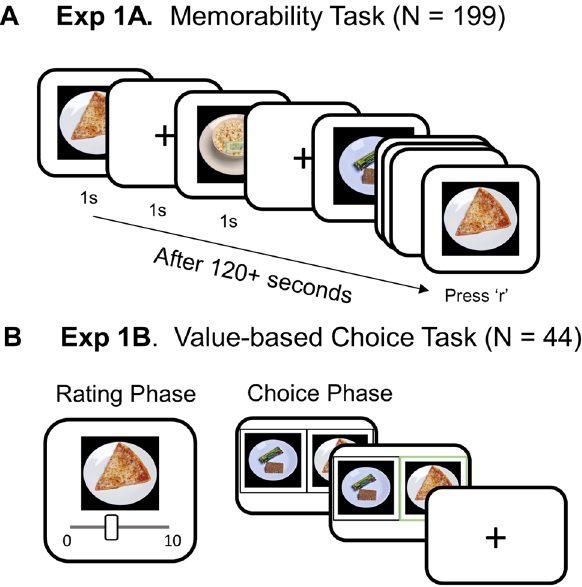
Figure 1. Diagram of tasks in Experiment 1. ( A ) Memorability task (Experiment 1A). Participants (N = 199) were asked to view a stream of images and press the ’r’ key on the keyboard if they saw a repeated image. Images were randomly classified as filler or target for each participant, and the spacing between the first and second display was different for targets and fillers. ( B ) Value-based choice task (Experiment 1B). In the rating phase, participants (N = 44) were asked to rate all of the 138 food items based on their preference (0 = least prefer to eat this food, 10 = most prefer to eat this food). In the choice phase, participants were asked to choose the item that they would like to eat as a snack. Participants had 3 s to make their choice. The chosen item was then highlighted for 500 ms. Choice trials were separated by 1000 ms intertrial interval. The photographs used in this figure are publicly available for download at https:// osf. io/ 483mx 22